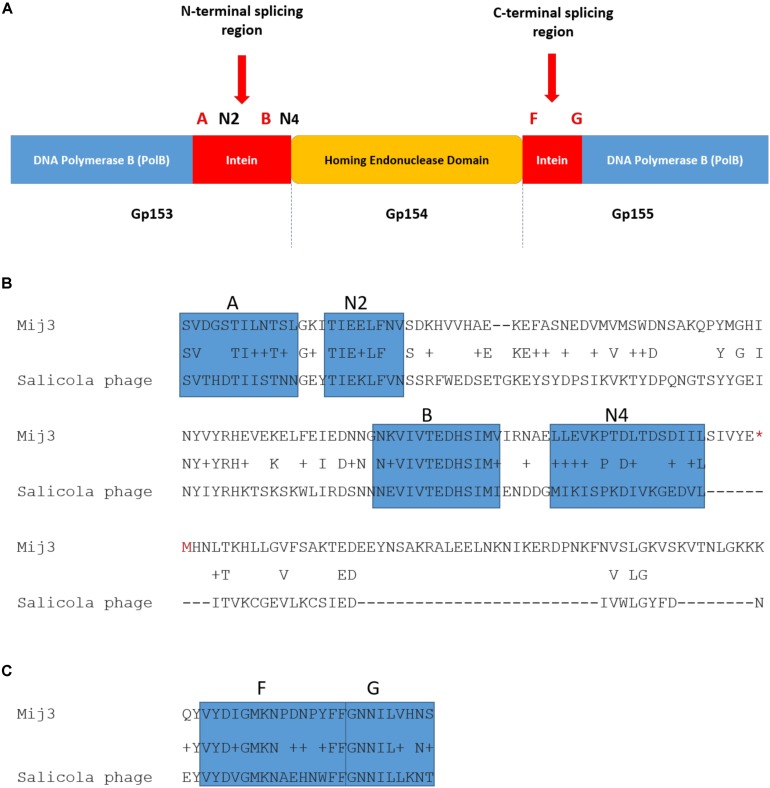
The presence of intein in MIJ3. (A) A diagram illustrating the location of the intein and its conserved motifs in the genome of MIJ3 jumbo phage. (B) N-terminal splicing region sequence alignment between inteins inserted in the PolB of MIJ3 and the Salicola phage SCTP-2 with the identified intein motifs highlighted as blocks A, N2, B, and N4. (C) C-terminal splicing region sequence alignment of the intein in both phages with the identified intein motifs are highlighted as blocks F and G.